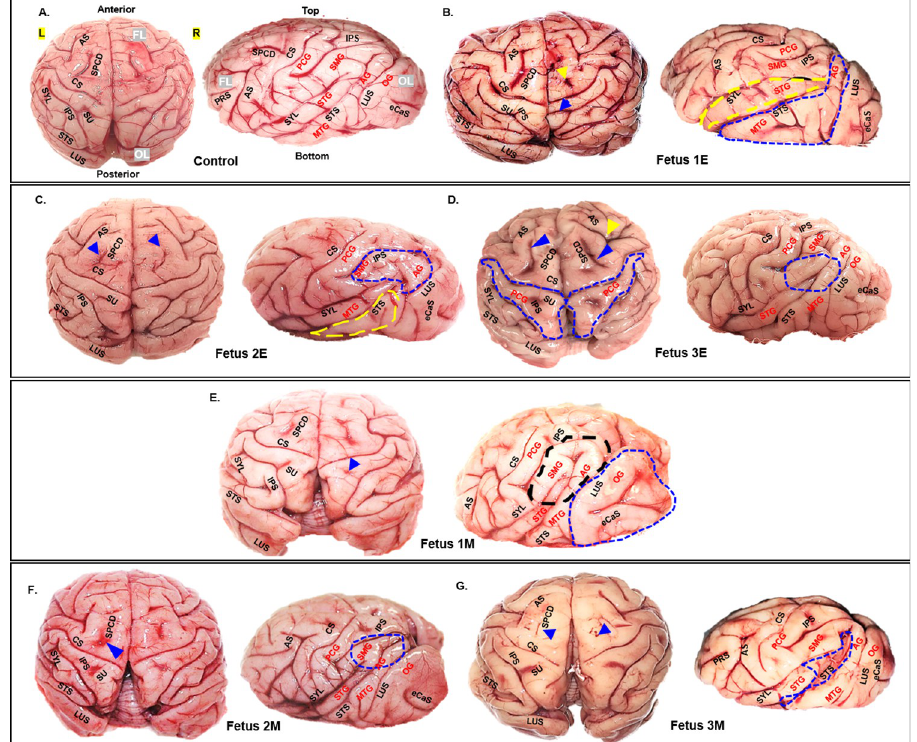
Fig 3. Gyri/sulci malformations in brains from fetuses form early and mid-gestation ZIKV inoculated dams compared to controls ( A ). Top and side view of fetal brains showing major gyri and sulci formations. Abnormal sulci (abnormal sulcal length and depth, asymmetry across cerebral hemispheres) or missing sulci are marked by arrows. Gyri malformations (enlargement, asymmetric across left and right cerebral hemispheres) are highlighted by dotted areas compared to the control fetal brain ( A ). Fetuses from early gestation inoculated dams (B, C, D) ; fetuses from mid- gestation inoculated dams ( E, F, G ). Frontal Lobe (FL), Occipital Lobe (OL), Parietal Lobe (PL), Left Cerebral Hemisphere (L), Right Cerebral Hemisphere (R), Arcuate Sulcus (ARS), Central Sulcus (CS), External calcarine Sulcus (eCaS), Inferior Parietal Sulcus (IPS), Lunate Sulcus (LUS), Superior Pre-central dimple (SPCD), Superior Post-central dimple (SU), Principal Sulcus (PRS), Superior Temporal Sulcus (STS), Sylvian Fissure/Lateral Sulcus (SYL), Postcentral Gyrus (PCG), Supramarginal Gyrus (SMG), Superior Temporal Gyrus (STG), Angular Gyrus (AG), Middle Temporal Gyrus (MTG), Occipital Gyrus